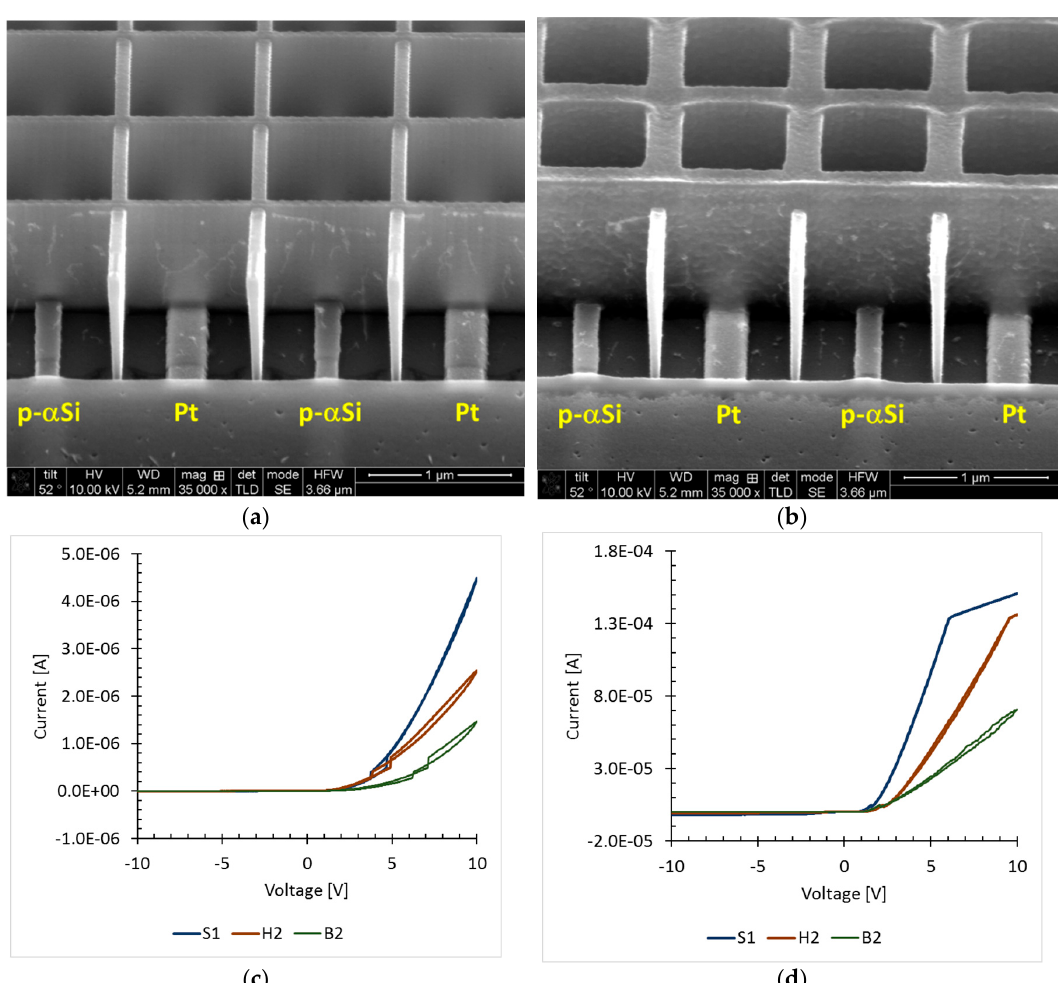
Figure 6. SEM images of the p-n junction devices with coated or infiltrated ZnO. ( a ) Device with dielectric core coated with ZnO. ( b ) Device with ZnO infiltrated SU-8 polymer. Current vs. voltage plots of p-n junctions with coated or infiltrated ZnO. Device S1 corresponds to a device with ZnO infiltrated SU-8 polymer. Device H2 corresponds to a ZnO coated dielectric core device. Device B2 corresponds to a non-patterned device where ZnO is coating the electrodes directly with no dielectric core mesh. Note the di ff erence in scales between UV o ff data ( c ) and UV on data ( d ) is almost two orders of